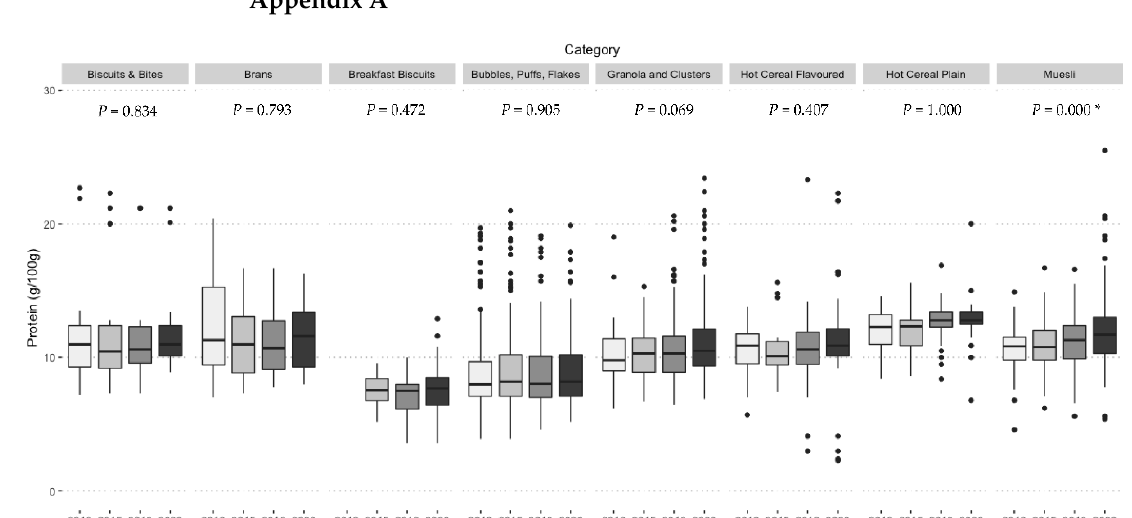
Figure A1. Protein content of breakfast cereals (g/100 g) between 2013, 2015, 2018, and 2020; p value comparing 2013 vs. 2020 (2015 vs. 2020 for breakfast biscuits). * Statistically significant p < 0.05.